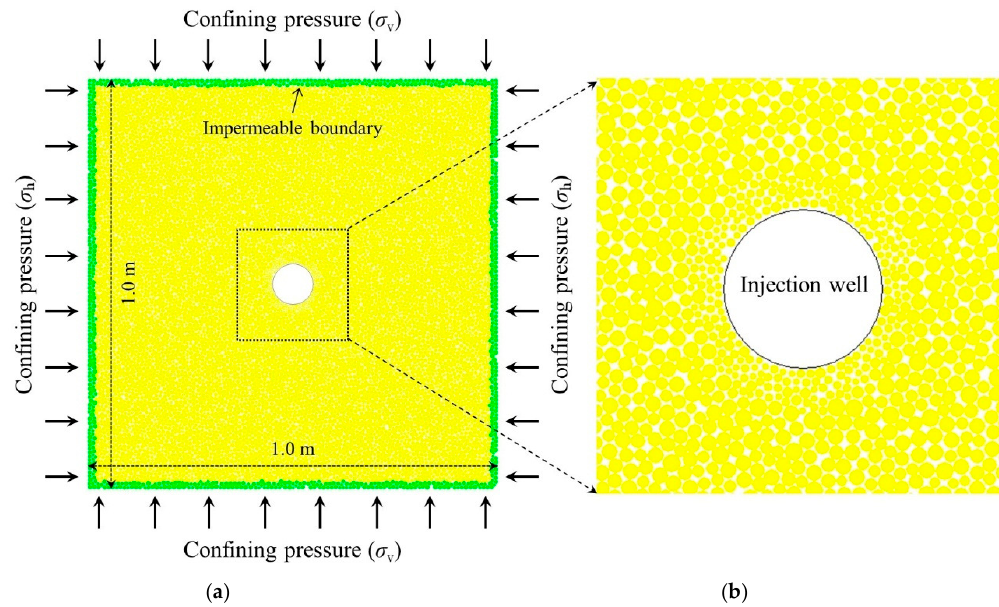
Figure 5. Granite model with a single injection well for hydraulic fracturing: ( a ) the model size and applied boundary conditions; and ( b ) particle densification near the injection well.